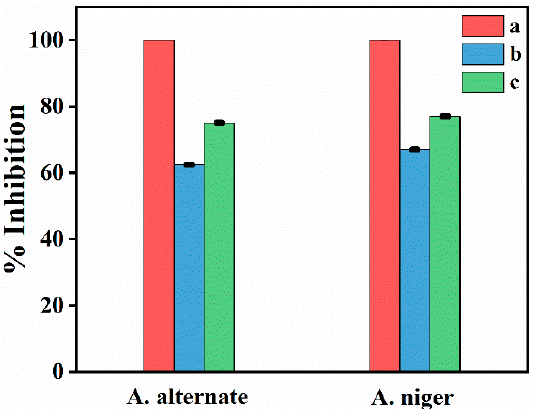
Figure 9. Antifungal activities of (a) Standard (Levofloxacin), (b) L-Ag-NPs and (c) R-Ag-NPs.